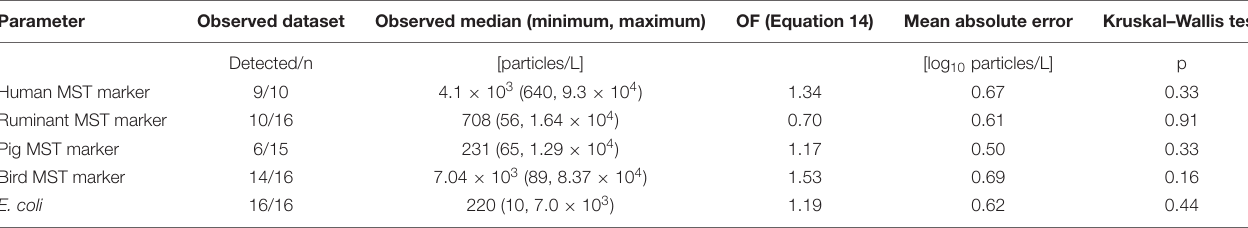
TABLE 5 | Model performance based on the observed microbial concentrations in 2010–2015 during days when the Danube discharged into the backwater branch and when rainfall